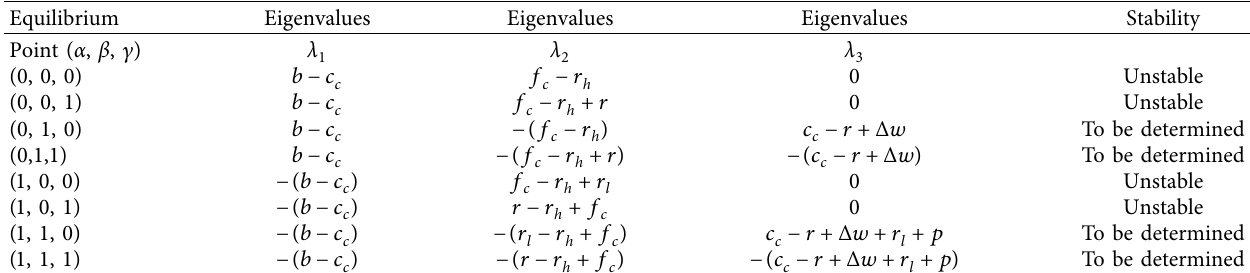
Table 4: Equilibrium stability